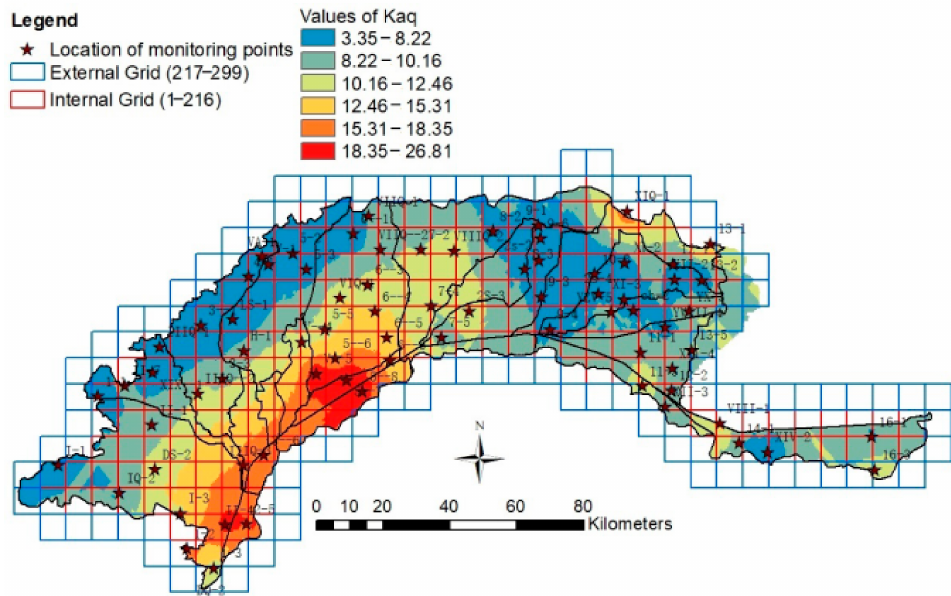
Figure 5. Spatial interpolation results of the horizontal hydraulic conductivity of the aquifer (Kaq).